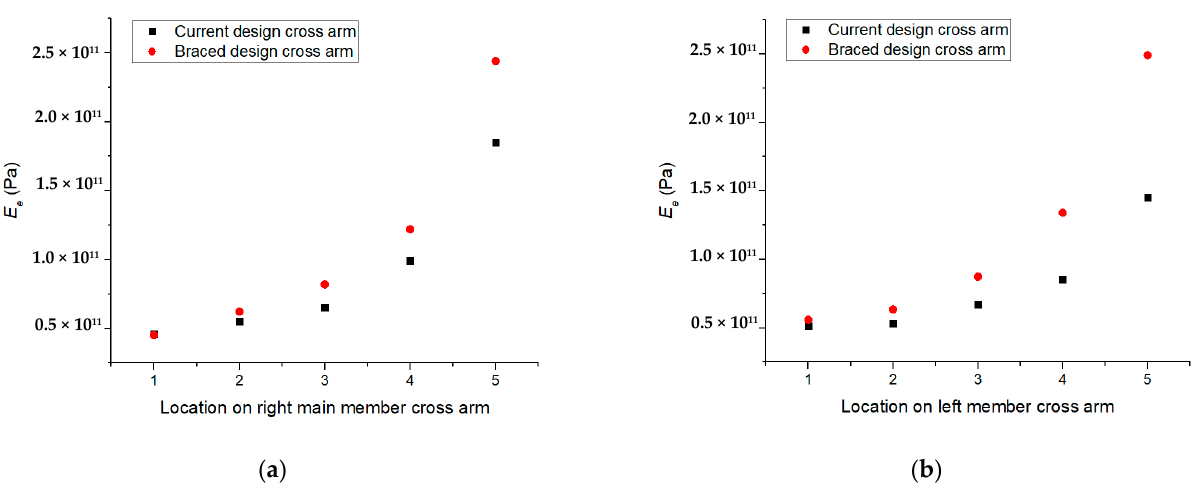
Figure 11. E e parameter for current and braced wooden cross-arms: ( a ) right; ( b ) left main members.